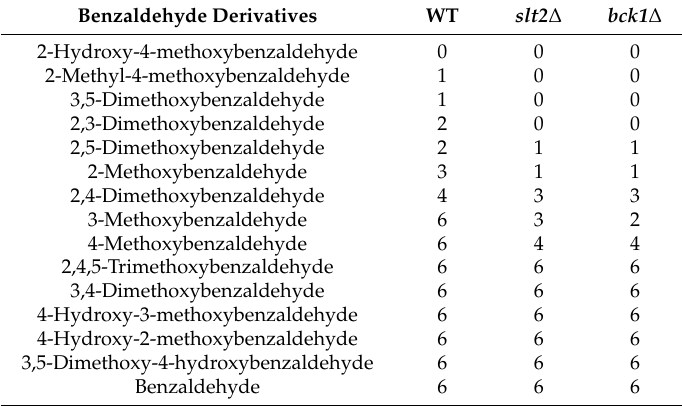
Table 3. Growth scores of yeasts at 5 mM (cutoff) of benzaldehyde derivatives during yeast dilution bioassay (0, No growth; 6, Full growth; See Experimental